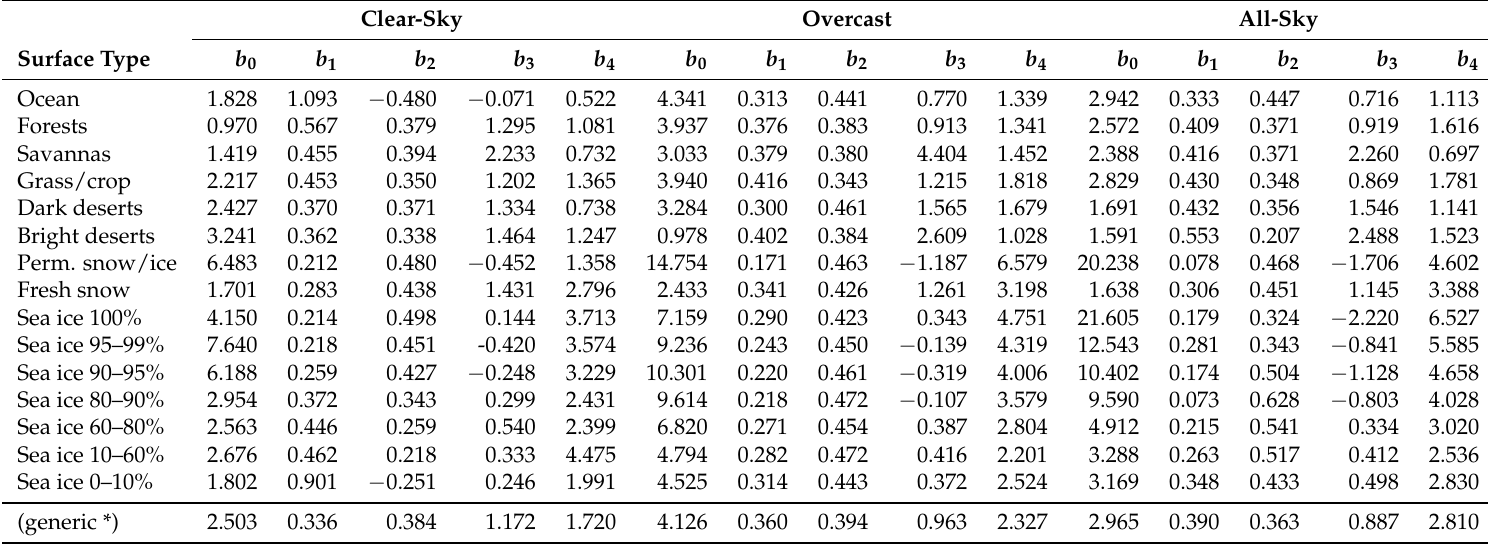
Table 3. Regression coefficients based on calibration subset (80% of the NTB pairs with strict matching criteria), stratified per surface type, for clear, overcast, and allsky conditions; Data: 2004–2005 (NOAA17+Terra), 2007–2008 (NOAA18+Aqua) and 2011–2012